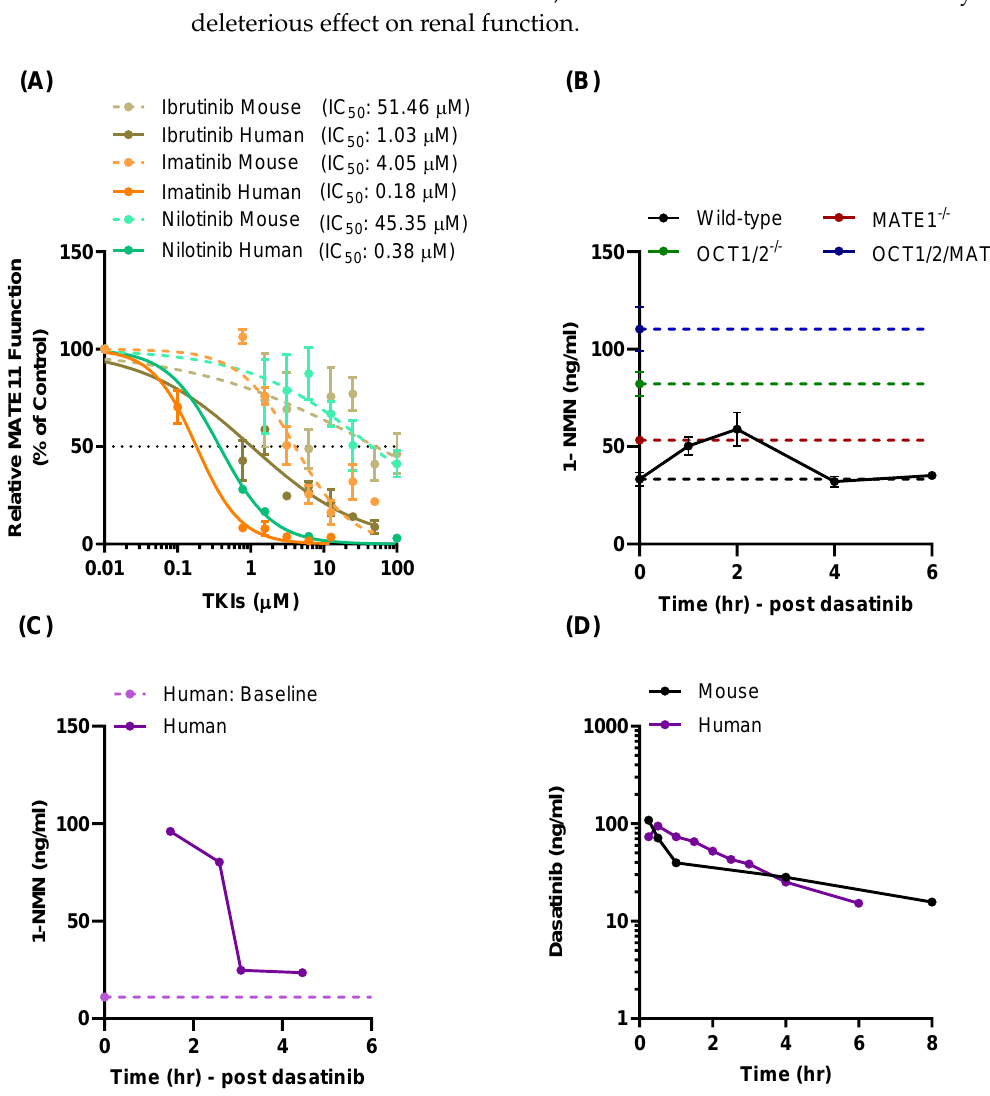
Figure 4. Characteristics of MATE1 inhibition by TKIs. ( A ) Comparison of IC 50 of several TKIs in HEK293 cells overex- pressing mouse or human MATE1. ( B ) Influence of mouse genotype and TKI treatment on levels of the MATE1 biomarker, N-methynicotinamide (1-NMN) in plasma. Dashed lines represent baseline levels of 1-NMN in wild-type, OCT1/2-, MATE1-, and OCT1/2/MATE1-deficient mice (n = 5 each), and solid lines represent concentration-time profiles of 1-NMN in wild-type mice after a single oral dose of dasatinib (15 mg/kg) ( p < 0.05 treated vs. baseline 1-NMN level in wild-type mice). All values represent mean ± SEM. ( C ) Plasma concentration-time profile of 1-NMN in a human patient after a single oral dose (p.o.) of dasatinib (100 mg). Dashed line represents baseline 1-NMN level in plamsa. ( D ) Plasma concentration time profile of dasatinib in mice (15 mg/kg; p.o.) and a human patient (100 mg; p.o.).